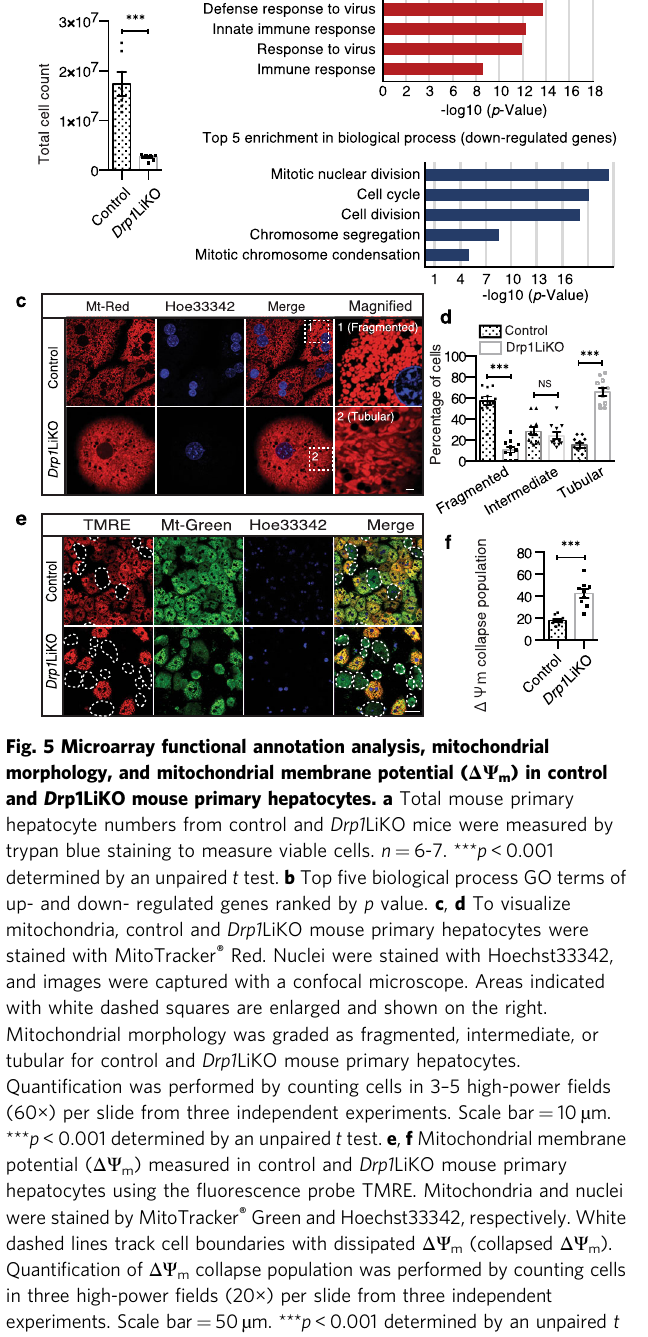
trypan blue staining to measure viable cells. n = 6-7. *** p < 0.001